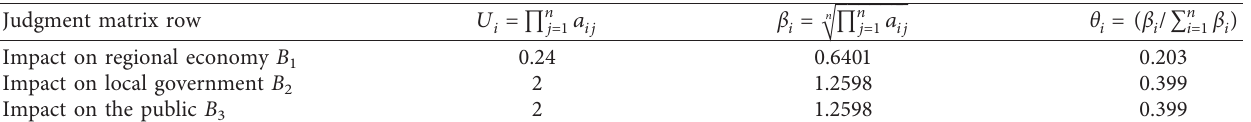
Table 4: Calculation of weight vector θ